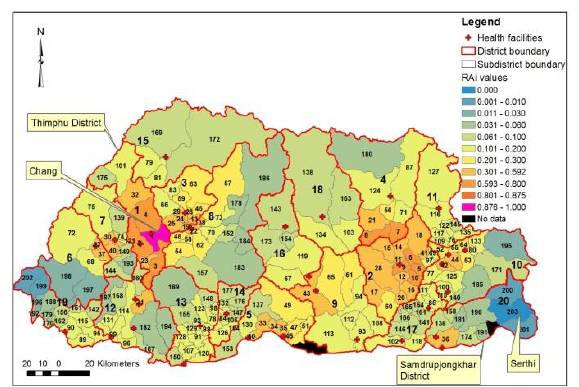
Figure 10: District and sub-districts accessibility ranking map for doctors